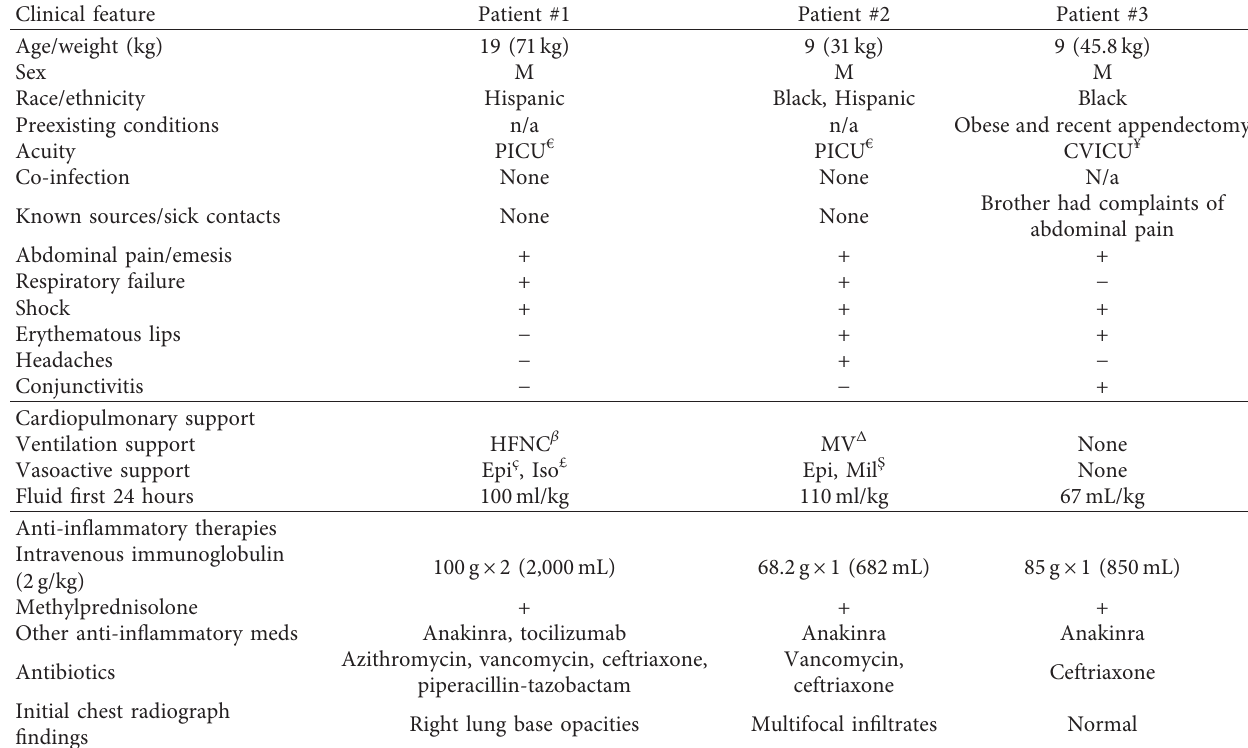
Table 1: Clinical features of 3 patients with multisystem inflammatory syndrome in